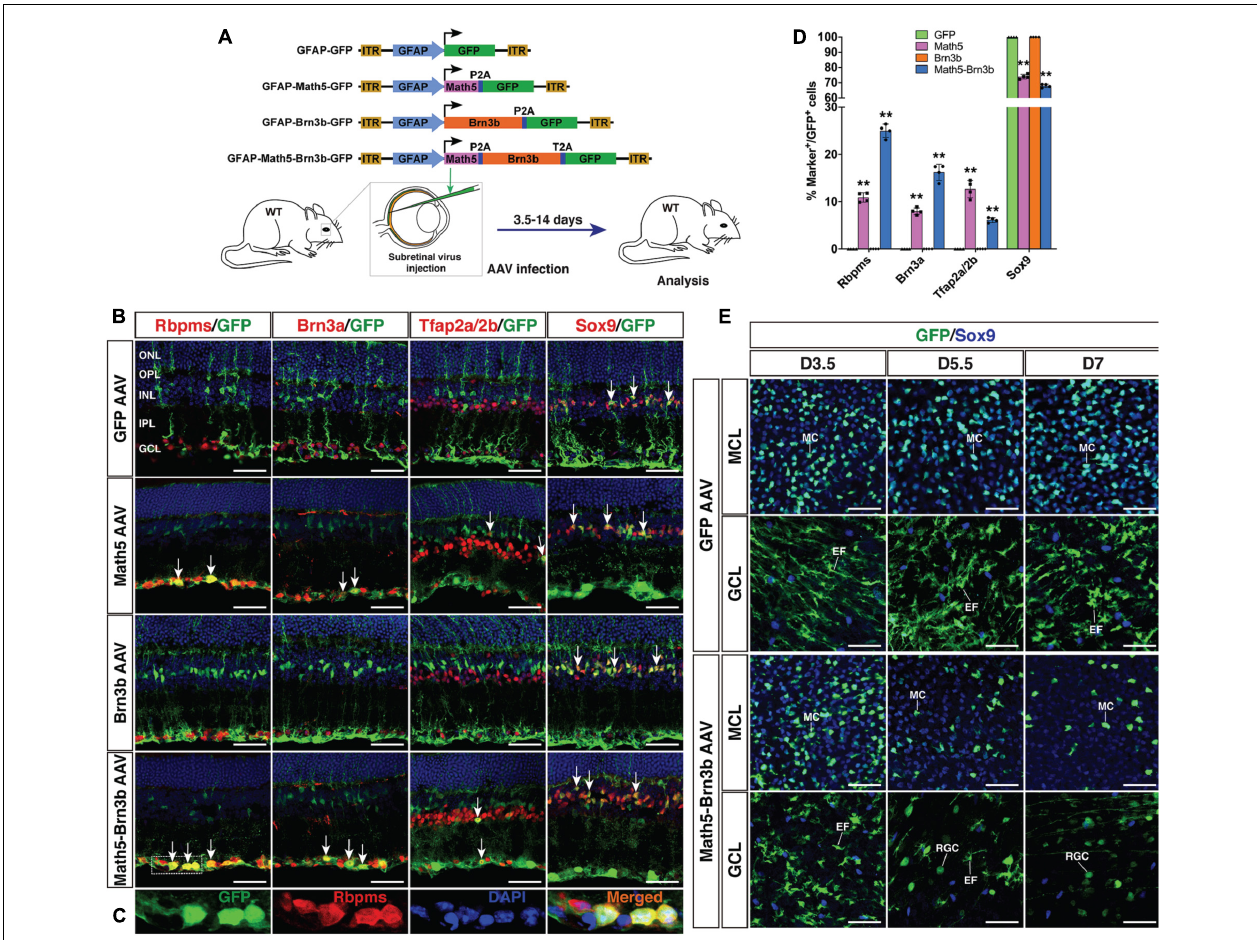
FIGURE 1 | Generation of RGCs by TF-mediated reprogramming of adult mouse MG. (A) Schematic of the AAV constructs and infection procedure to generate RGCs in adult wild-type (WT) mice. (B,C) Two weeks after infection with GFAP-GFP, GFAP-Math5-GFP, GFAP-Brn3b-GFP or GFAP-Math5-Brn3b-GFP AAVs, sections from infected retinas were double-immunolabeled with the indicated antibodies and counterstained with nuclear DAPI. Arrows point to representative co-labeled cells. Shown in (C) are higher magnification single-plane confocal images of the outlined region in (B) . (D) Quantitation of GFP+ cells that become immunoreactive for Rbpms, Brn3a, Tfap2a/2b or Sox9 in retinas infected with GFAP-GFP, GFAP-Math5-GFP, GFAP-Brn3b-GFP, or GFAP-Math5-Brn3b-GFP AAVs. Data are presented as mean ± SD ( n = 4). Asterisks indicate significance in two-way ANOVA test with Bonferroni’s correction: ** p < 0.0001. (E) At 3.5 (D3.5), 5.5 and 7 days after viral infection, flat-mounts of adult mouse retinas infected with GFAP-GFP or GFAP-Math5-Brn3b-GFP AAVs were immunostained for both GFP and Sox9. The confocal images are focused on the Müller cell layer (MCL) or ganglion cell layer (GCL). EF, MG endfoot; GCL, ganglion cell layer; INL, inner nuclear layer; IPL, inner plexiform layer; MC, Müller cell; MCL, Müller cell layer; ONL, outer nuclear layer; OPL, outer plexiform layer; RGC, retinal ganglion cell. Scale bars = 40 µ m (B,E)